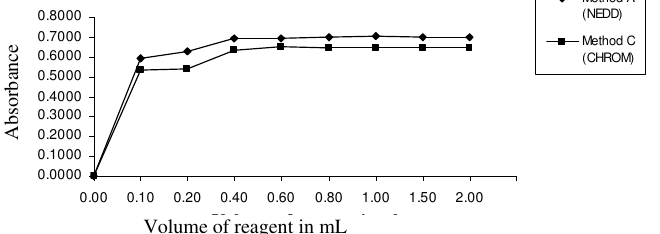
Figure 2. Effect of N -(1-napthyl) ethylenediamine dihydrochloride (NEDD) and chromotropic acid